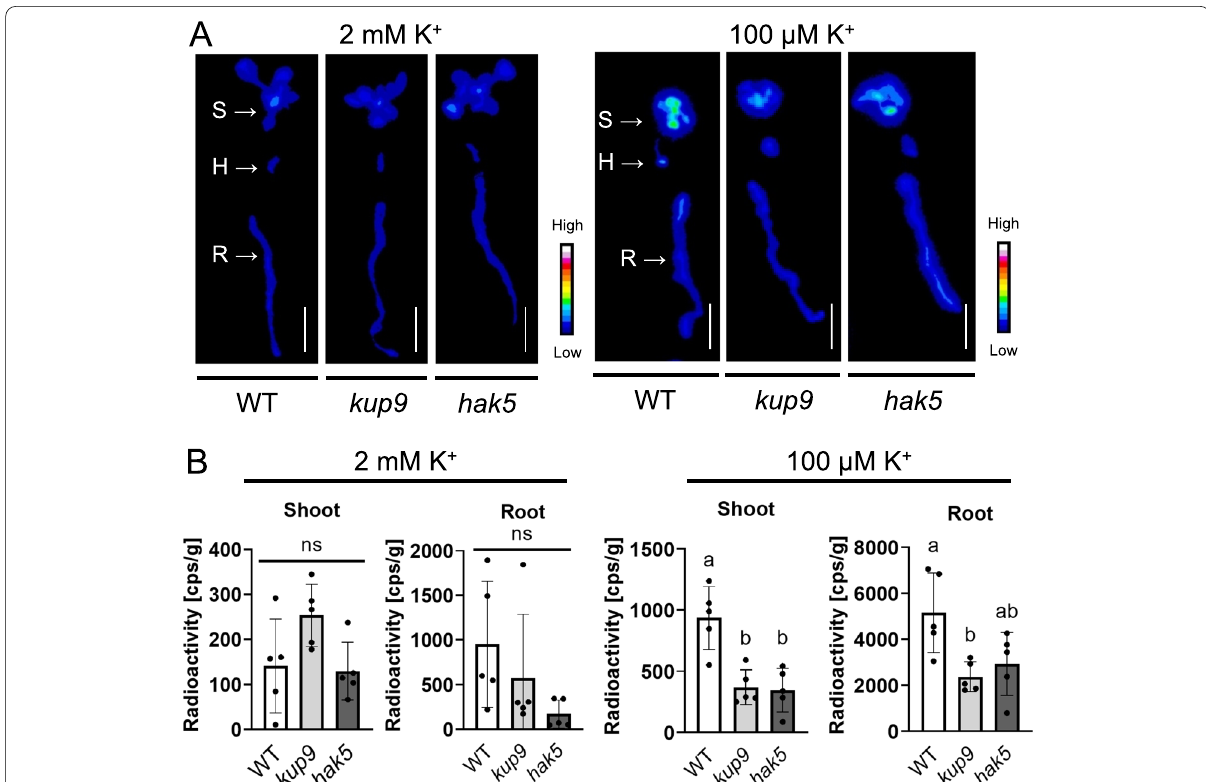
Fig. 5 Distribution of 43 K in kup9 and hak5. A Representative autoradiography of the excised shoots (S), hypocotyls (H) and roots (R) of wild-type, kup9 and hak5 plants after uptake of 43 K. Plants were grown on synthetic agar medium containing 2 mM K + (left) or l00 μM K + (right) for 2 weeks before being incubated for 1 h in hydroponic medium containing 43 K. B Quantification 43 K-uptake into shoots and roots of the plants shown in panel (A). Data are shown as mean S.D. of n 5 independent plants. P < 0.05, ns, not significant ( P > 0.05); one-way ANOVA. Scale bars represent ± = 1